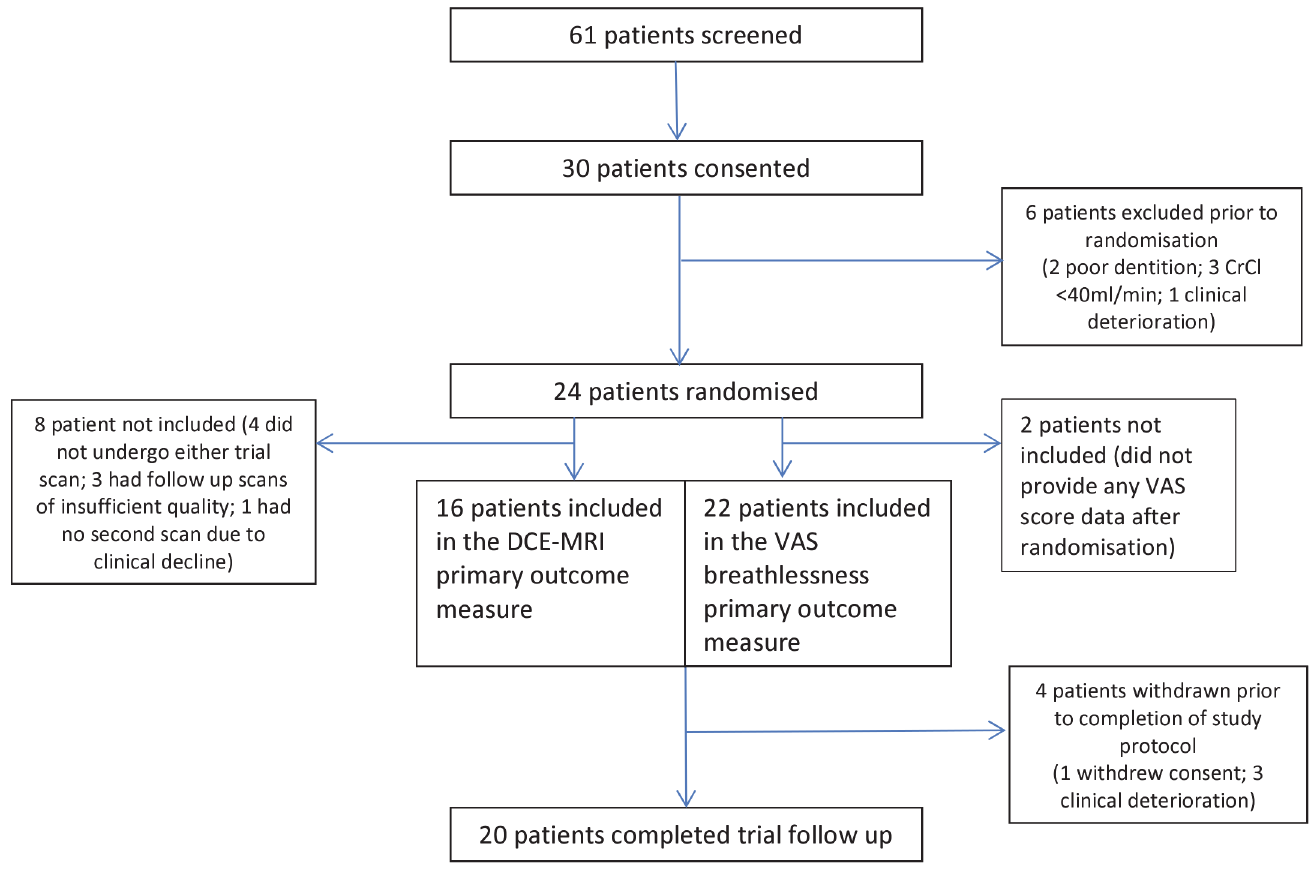
Fig 1. Patient flow